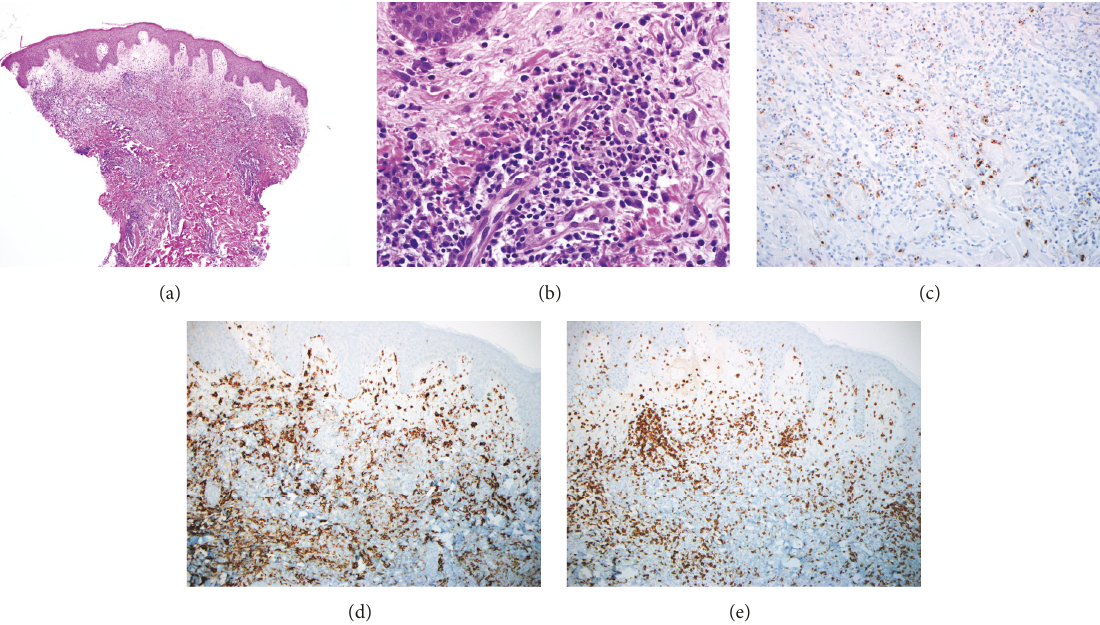
Figure 2: Biopsy findings . (a) Histological section showing fairly prominent papillary dermal edema and a somewhat dense dermal infiltrate comprised of mixed inflammatory cells (hematoxylin-eosin, original magnification: × 40). (b) Many large histiocytic cells are present as well as lymphocytes and scattered neutrophils (hematoxylin-eosin, original magnification: × 400). Leukocytoclastic debris is noted, but evidence of vasculitis is lacking. (c) Myeloperoxidase immunohistochemical stain reveals scattered neutrophils but is negative in the histiocytic cells (original magnification: × 200). (d) Histiocytic cells are confirmed to be histiocytes and not mononuclear myelocytes (CD163 immunohistochemical stain, original magnification: × 100). (e) Background T lymphocytes (CD3 immunohistochemical stain, original magnification: ×